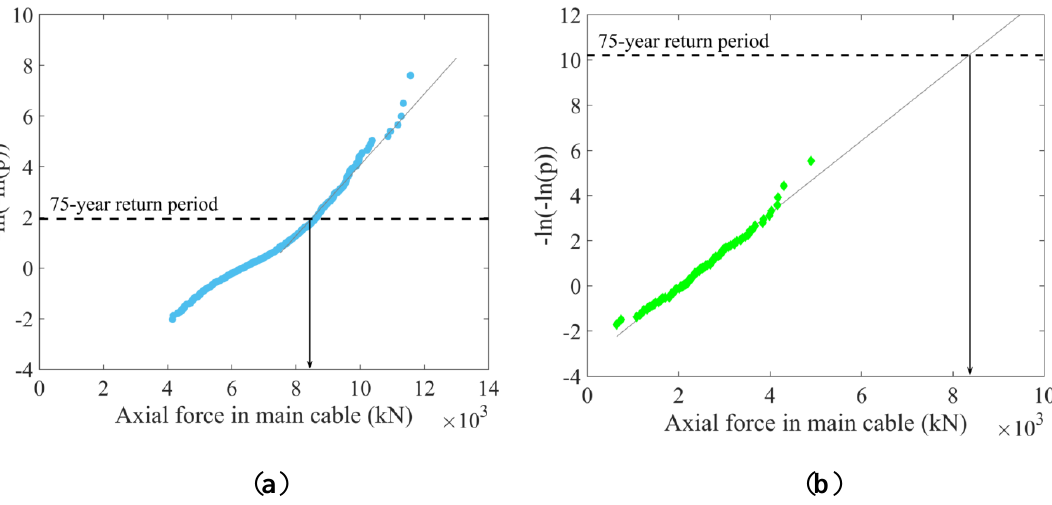
Figure 12. Comparison of cable forces for jammed and regular traffic: ( a ) Non-recurrent (jammed) from HTLF cluster; ( b ) Maximum-per-day cable forces due to regular traffic from MTHF cluster.